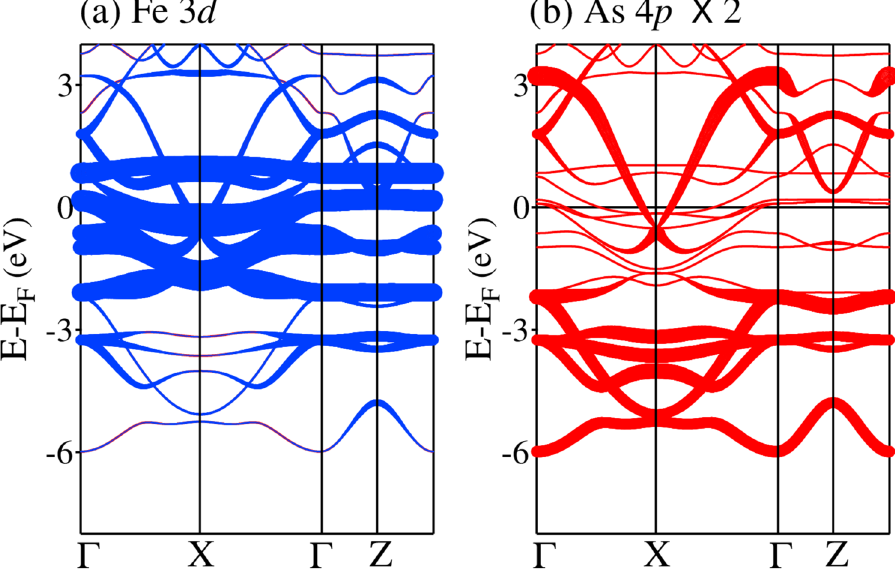
Figure 14. Band structure of CaFe 2 As 2 in the tetragonal structure highlighting ( a ) Fe 3 d and ( b ) As 4 p character; the thickness of lines represents the weight of the character. As 4 p contributions are rescaled by a factor of 2 to enhance the visibility of the